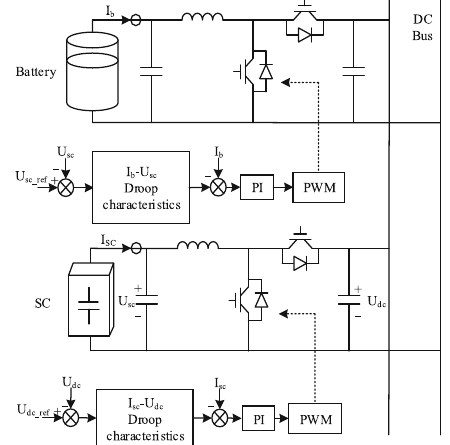
Fig. 4 Droop control characteristic curve of hybrid energy storage Fig. 5 Hybrid energy storage droop control